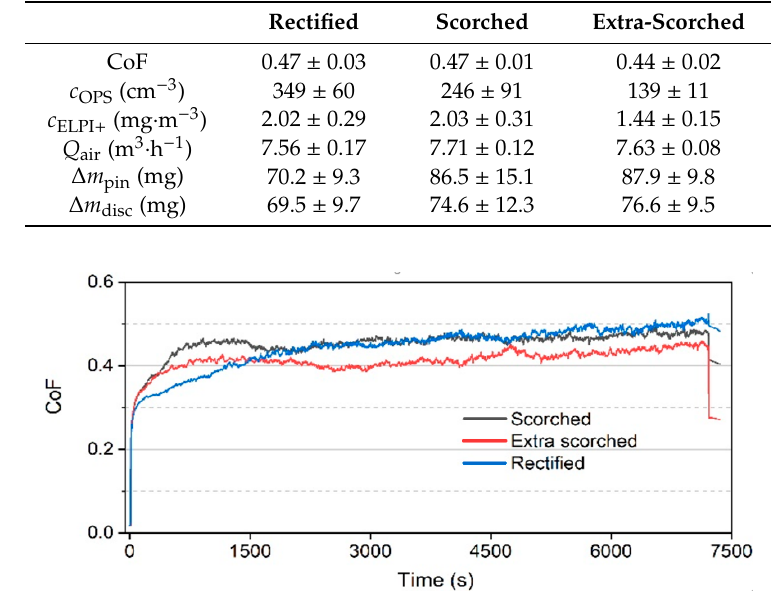
Figure 7. Representative measured PM10 curves for the three surface types.